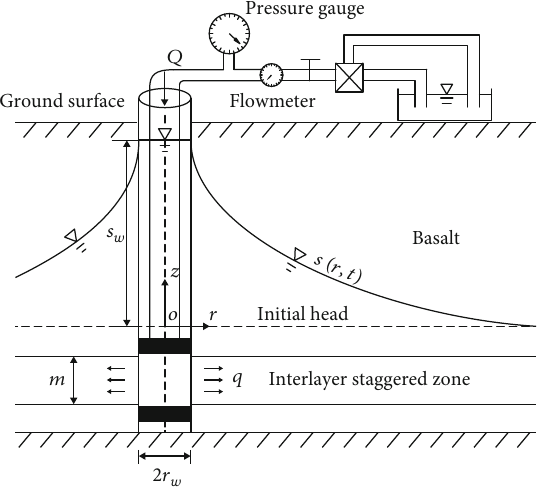
Figure 2: The schematic diagrams of the